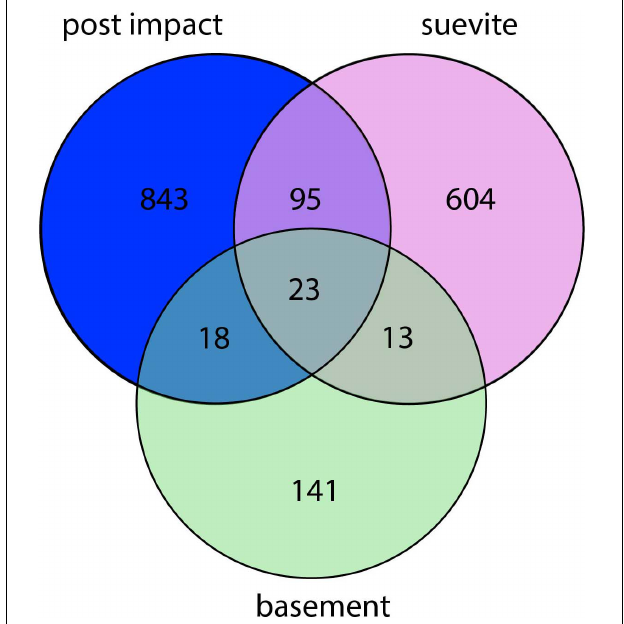
FIGURE 4 | Venn diagram showing the number of microbial taxa (assigned at the lowest identified taxonomic levels) in the three lithologies. The non-overlapping parts of the circles show the number of taxa that are unique to each lithology, whereas the overlapping parts of the circles display the number of taxa that are shared between the